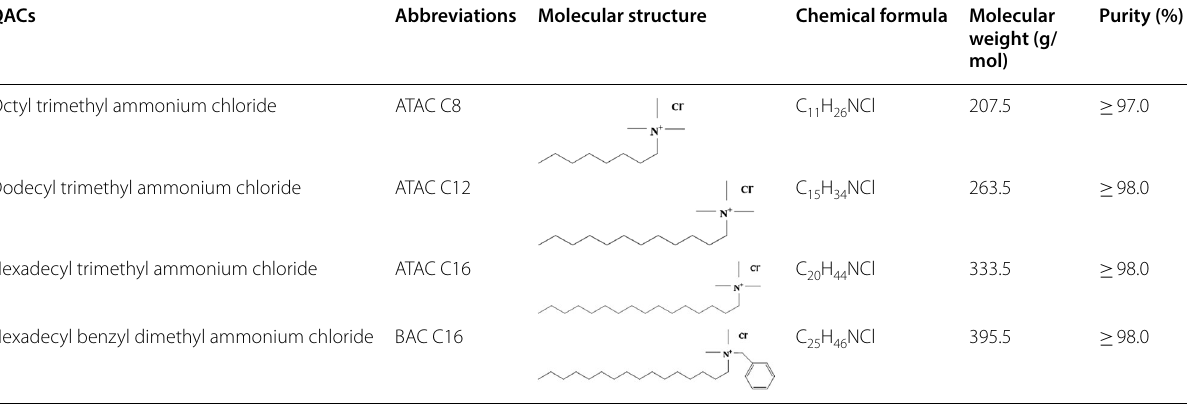
Table 1 Information of the four kinds of QACs used in this study QACs Abbreviations Molecular